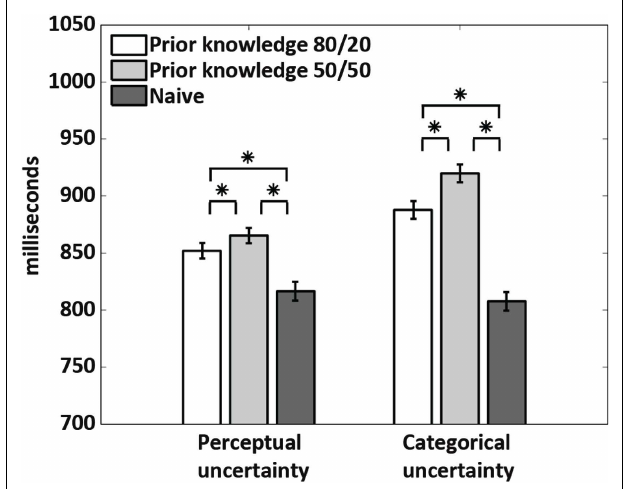
FIGURE 3 | Response times. The 80/20 cue gave a speed advantage to the prior knowledge subjects relative to the 50/50 cue in the same subjects. Across the prior knowledge subjects, response times were longer for the subjects performing under categorical than perceptual uncertainty.This difference was not seen in the naïve subjects. Stars indicate p < 0.0001, calculated via a two-tailed t -test across conditions.